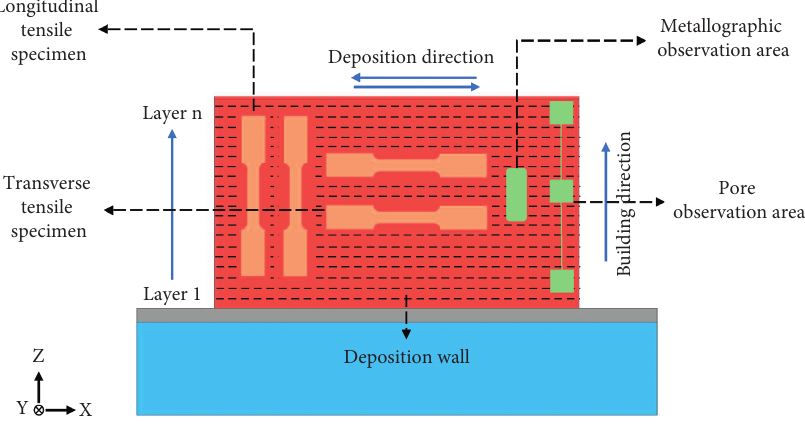
Figure 3: Test area of the deposition